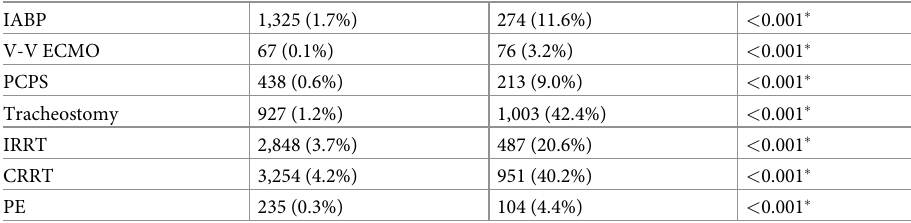
Table 3. Therapy in